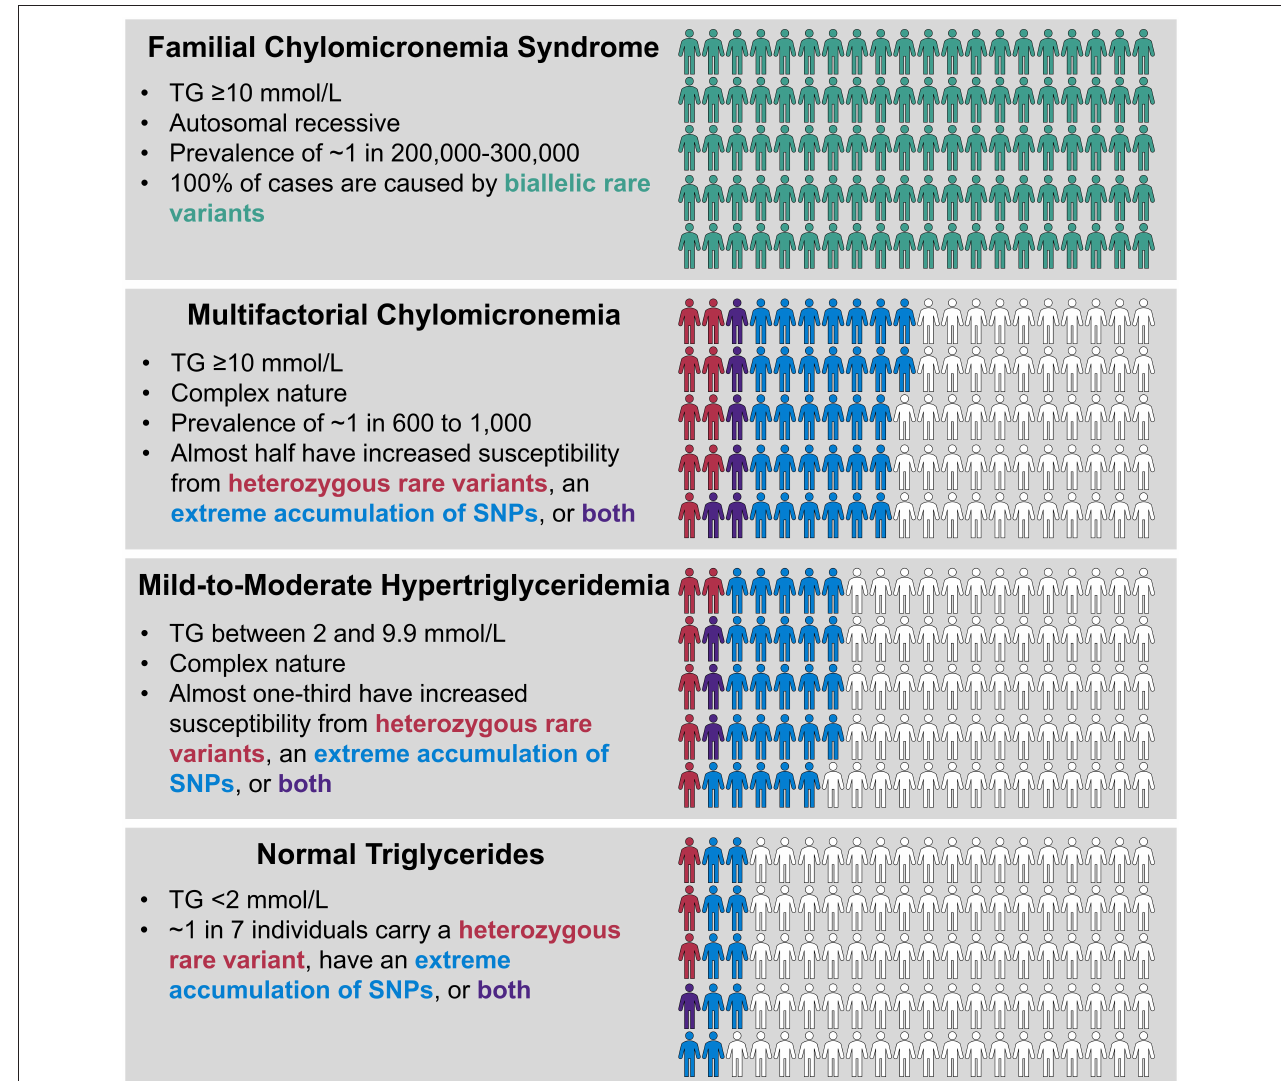
FIGURE 3 | Genetic determinants of hypertriglyceridemia. FCS and MCM both present with severe hypertriglyceridemia with TG levels ≥ 10 mmol/l ( ≥ 885 mmol/L), while TG levels in mild-to-moderate hypertriglyceridemia are lower, ranging from 2.0 to 9.9 mmol/L (175–885 mg/dL). FCS is a very rare condition and is the only true classical monogenic phenotype, showing recessive inheritance with biallelic variants in LPL , APOA5 , APOC2 , GPIHBP1 , and LMF1 genes. MCM and mild-to-moderate hypertriglyceridemia have complex underlying genetics, showing statistical excess of heterozygous rare variants in LPL , APOA5 , APOC2 , GPIHBP1 , and LMF1 genes or extreme polygenic scores or both, compared to the normal population, with frequencies denoted by color scheme as shown. Each phenotype shows 100 individuals and the proportion of relevant genetic factors, but note the extreme differences in population prevalence for each condition, which is not depicted here (please also refer to Figure 1 ). Non-genetic, environmental factors also play a role in expression of the complex phenotypes. FCS, familial chylomicronemia syndrome; MCM, multifactorial chylomicronemia; TG,